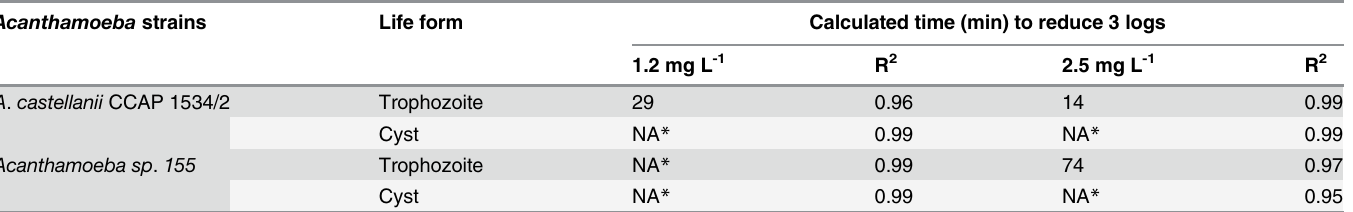
Table 2. Calculated time for a 3-log reduction of two Acanthamoeba strains treated separately by its life stage, cyst or trophozoite at 1.2 mg L -1 and 2.5 mg L -1 of free chlorine. Inactivation kinetics of amoeba strains adjusted to a first-order model and to a biphasic decay model ( * ). R 2 values showed the robustness of the model. NA (not